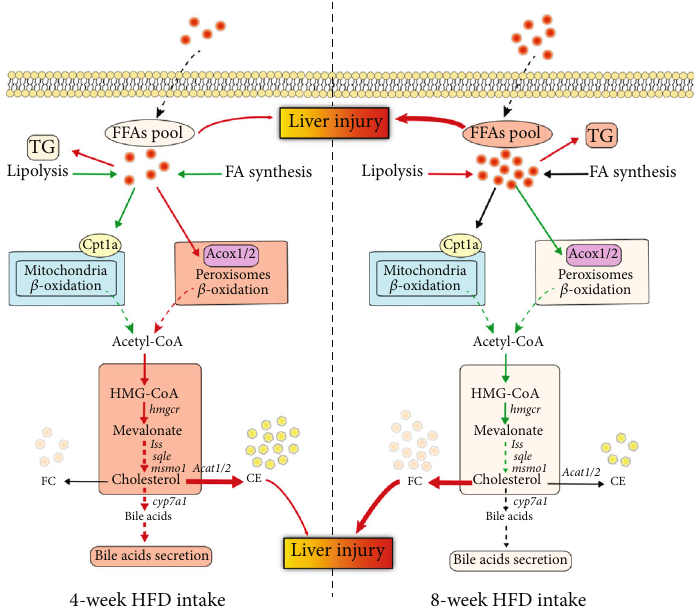
Figure 5: A hypothetical diagram showing that short-term (4 weeks) HFD intake triggers protective mechanism against FFA accumulation and liver injury through promoting hepatic cholesterol/bile acid synthesis and fl ux, which might be linked to stimulated peroxisomal β - oxidation for supply of substrate acetyl-CoA. De fi cient hepatic peroxisomal β -oxidation might block the conversion of FFAs to cholesterol and bile acids and then failed to alleviate FFA accumulation in fi sh after long-term (8 weeks) HFD intake. Therefore, peroxisomal β -oxidation-mediated cholesterol-bile acid fl ux might serve an adaptive metabolism in Nile tilapia fed an HFD. FFAs: free fatty acids; TG: triacylglycerols; hmgcr : 3-hydroxy-3-methylglutaryl-coenzyme A reductase; sqle : squalene monooxygenase; lss : lanosterol synthase; msmo1 : methylsterol monooxygenase 1; cyp7a1 : cholesterol 7 alpha-hydroxylase; Acox1/2: acyl-CoA oxidase 1/2; acat1/2 : acetyl-CoA acetyltransferase